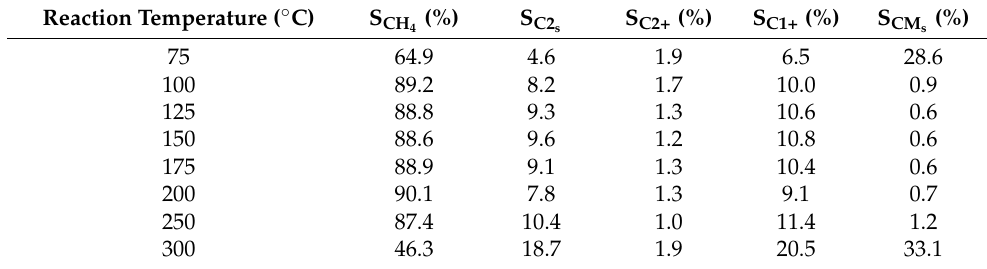
), C 2 hydrocarbons (S C2 ), hydrocarbons with more than two s 4 ) for SL-Pd. s